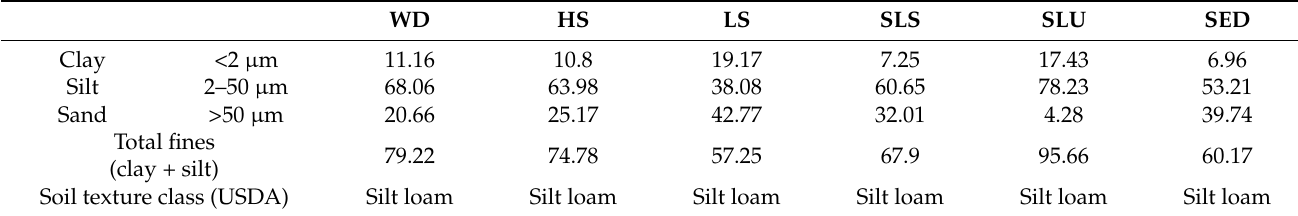
Table 4. Particle size classification of gold mine waste